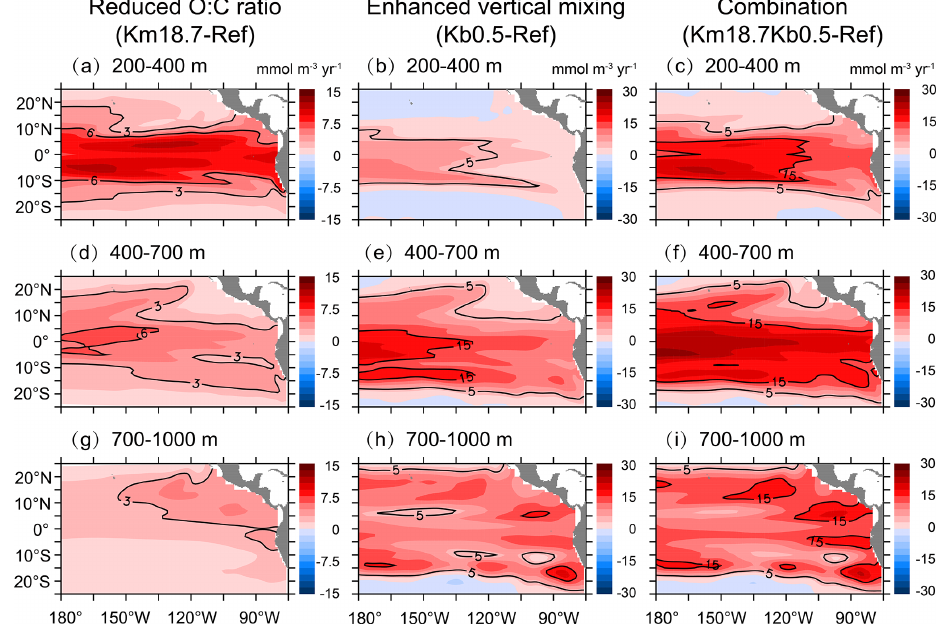
Figure 7. Changes in DO concentration over (a, b, c) 200–400m, (d, e, f) 400–700m, and (g, h, i) 700–1000m due to a reduced O : C utilization ratio ( a, d, g ), an enhanced vertical mixing ( b, e, h ), and the combination of a reduced O : C utilization ratio and an enhanced vertical mixing ( c, f, i ).